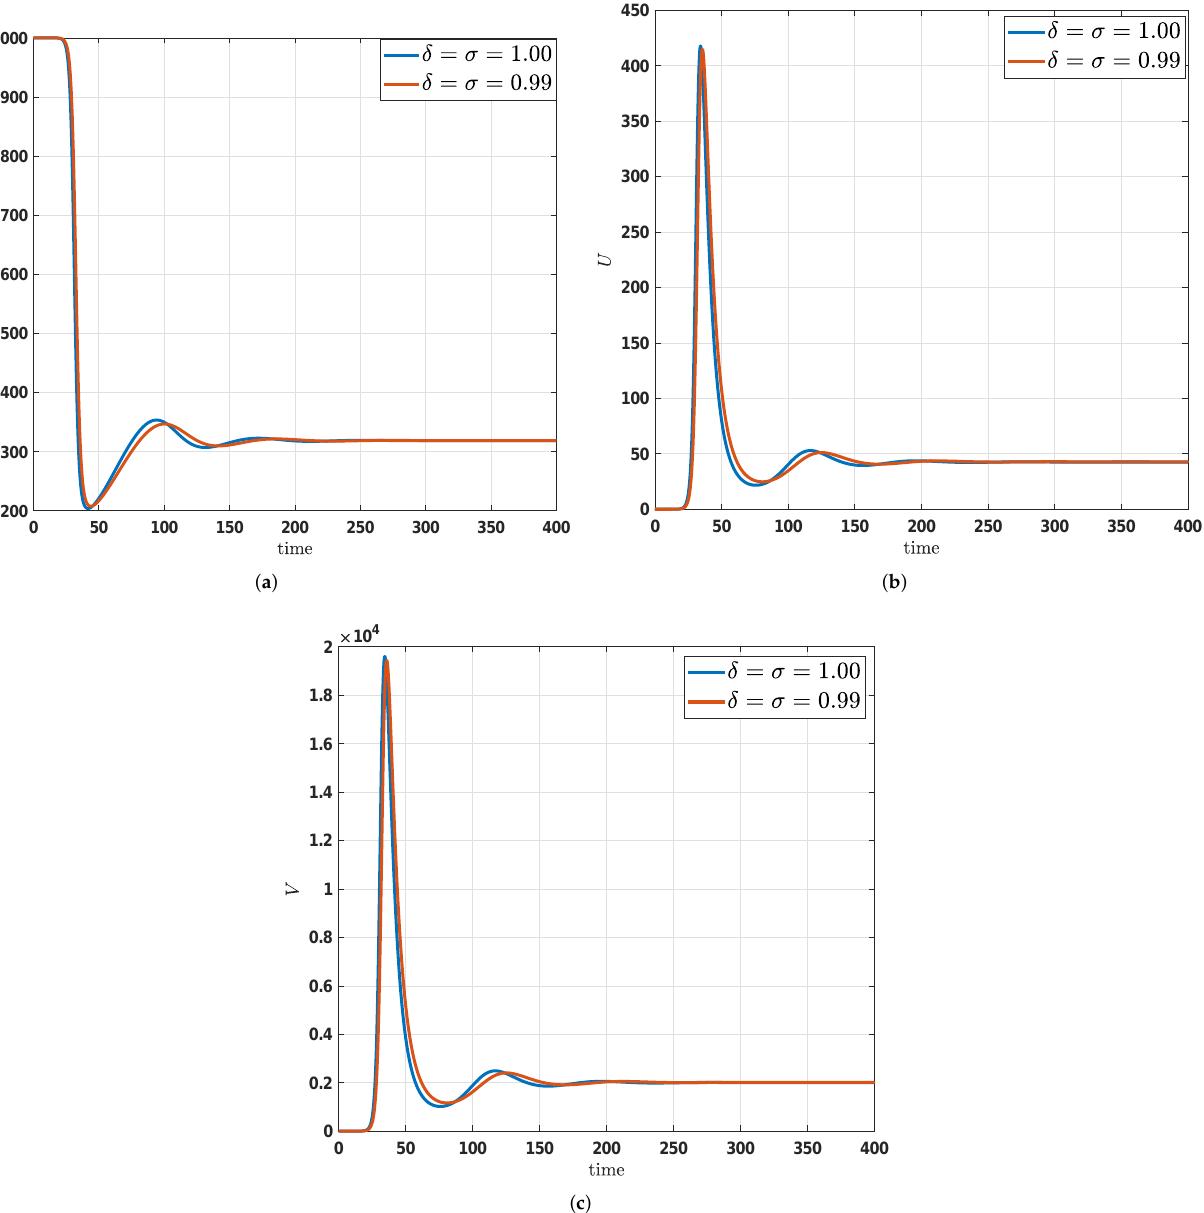
Figure 4. Numerical trajectories by varying both fractal order and fractional order δ = σ = 1.00,0.99 via the Newton polynomials method. ( a ) A 0.01-variation in fractal-fractional orders of susceptible CD4 + T-cells. ( b ) A 0.01-variation in fractal-fractional orders of infectious CD4 + T-cells. ( c ) A 0.01-variation in fractal-fractional orders of free particles of the infection of the HIV-1 virus in the